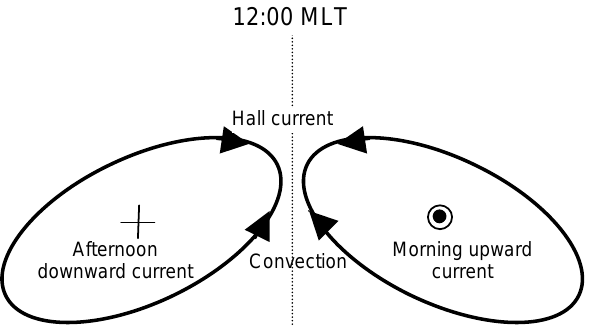
Fig. 1. Schematics of the convection-current system in the North- ern Hemisphere ionosphere during the preliminary impulse. The system is reversed during the main impulse.